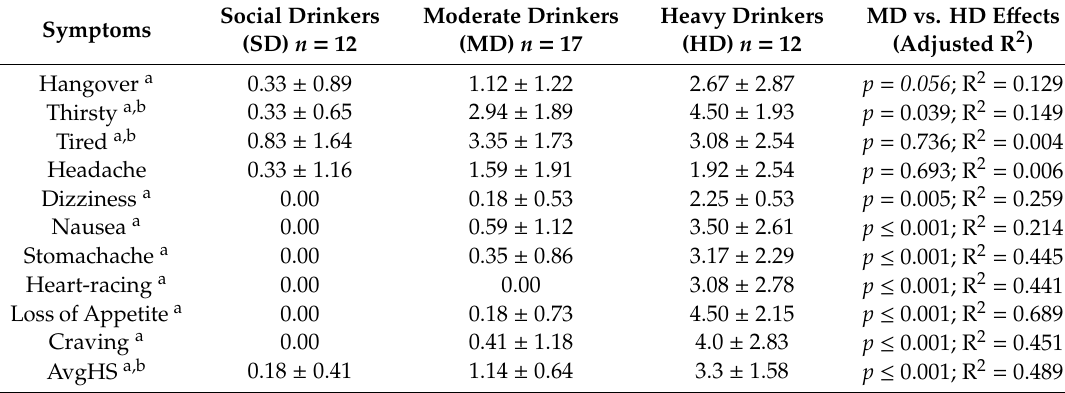
Table 2. Scores of hangover symptoms in social, moderate, and heavy drinkers. E ff ects of di ff erence between moderate and heavy